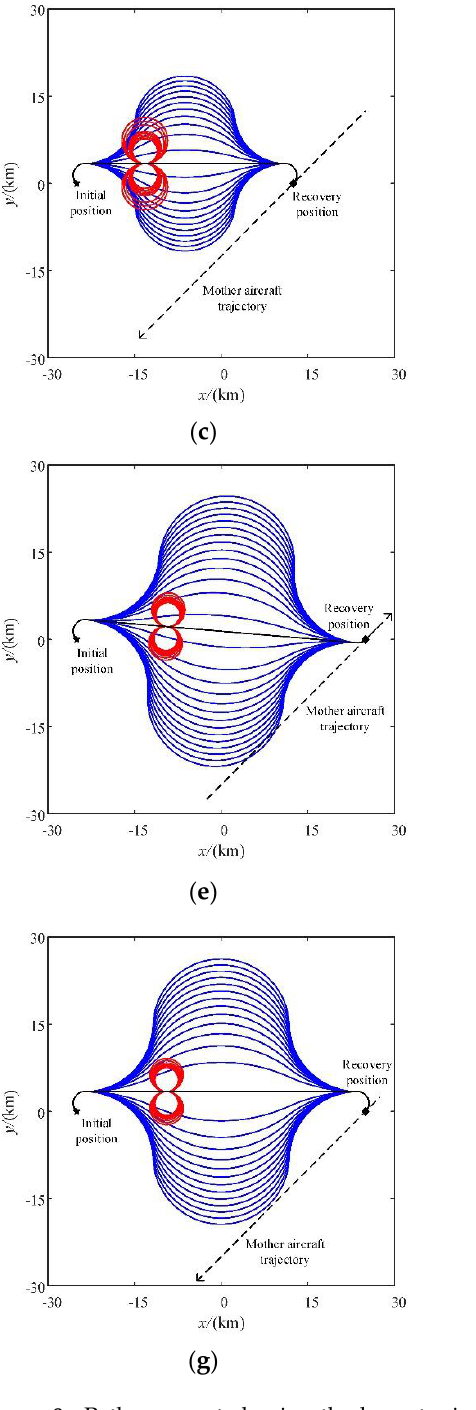
Figure 8. Paths generated using the homotopic approach. ( a – d ) The coordinates of the recovery position are (12.5,0) and the heading angles are 45°, 135° , −135 ° , and −45 °; ( e – h ) The coordinates of the recovery position are (25,0) and the heading angles are 45°, 135° , −135 ° , and −45 °. The path length coverage intervals under the different conditions are given in Table 2. For each case in the simulations, we can find that all of the expected path lengths can be covered by using a combination of the two path homotopies.